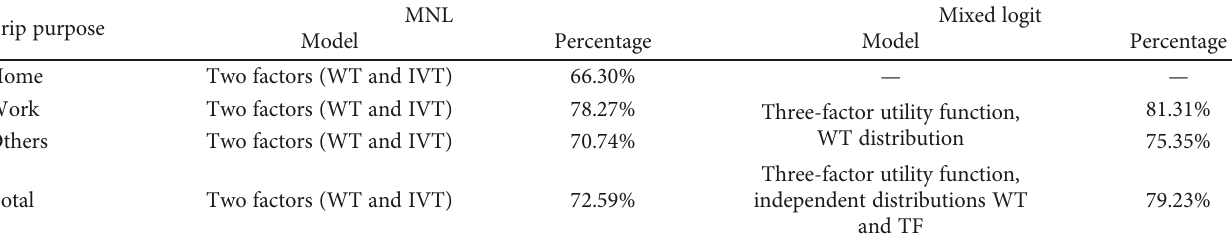
Table 5: Results for alighting station estimation based on selected MNL and mixed logit